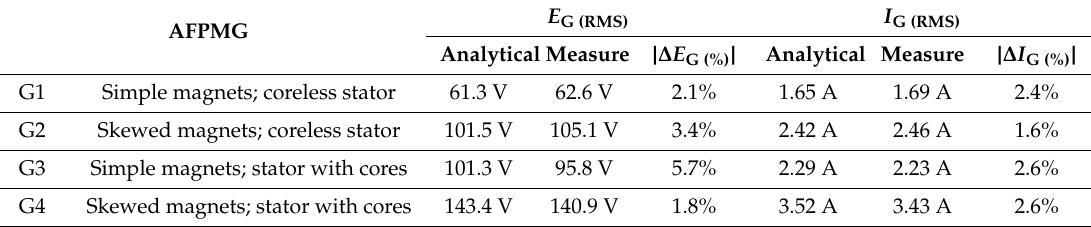
Table 3. Comparison of the results obtained from analytical models and laboratory